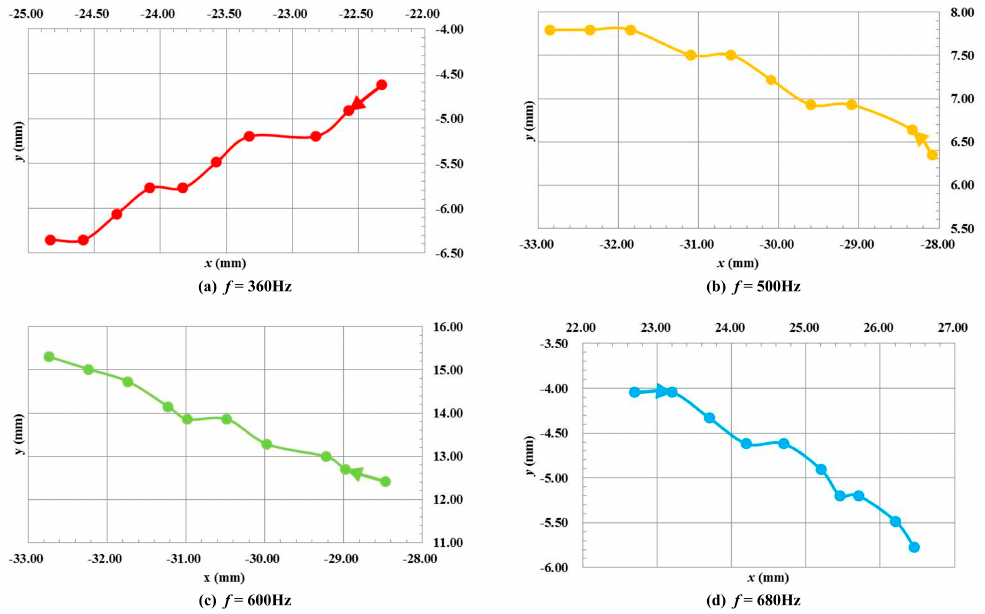
Figure 7. Moving trace of droplets at different frequencies.